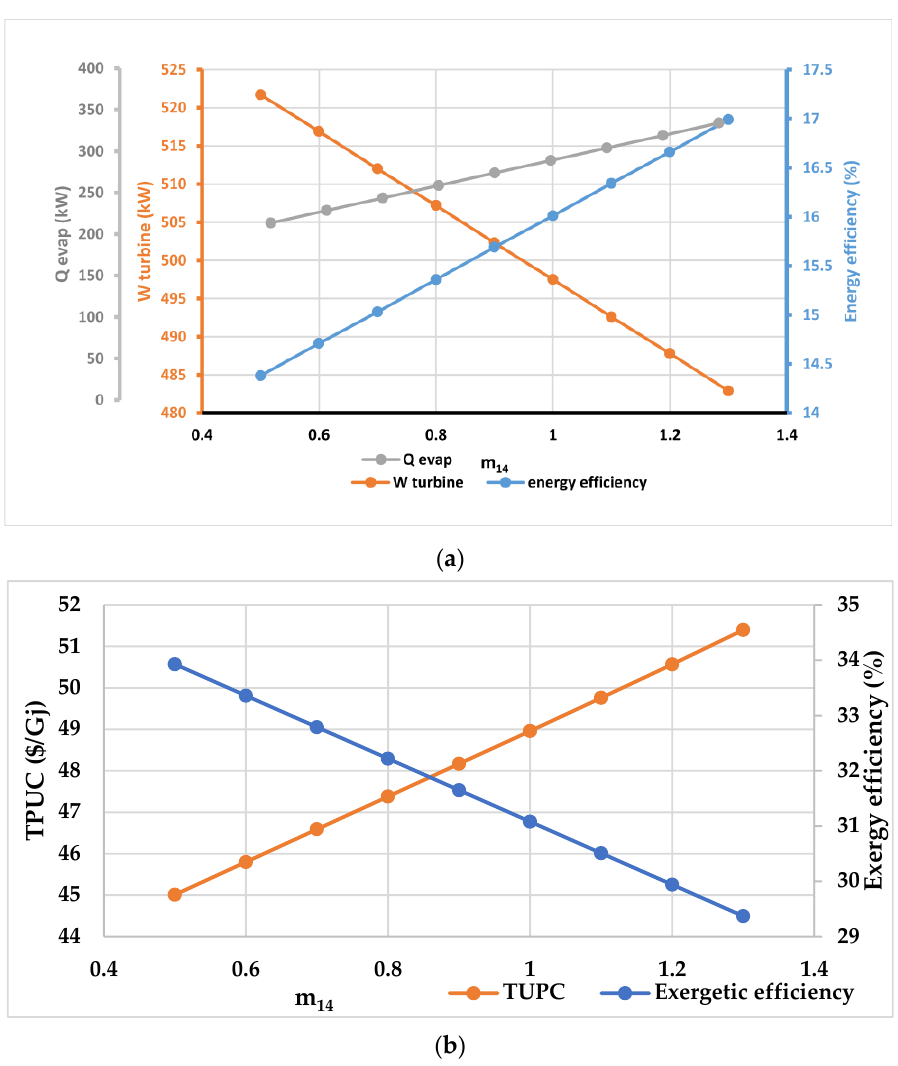
Figure 13. ( a ) Effect of the secondary mass flow rate of the second ejector on energy efficiency, cooling, and power generation. ( b ) Effect of the secondary mass flow rate of the second ejector on exergy efficiency and TPUC.